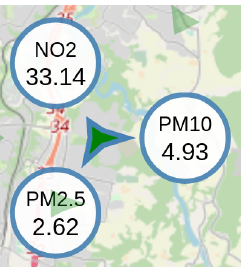
Figure 9. Close-up of a star glyph used in the map view. Each spike angle corresponds to a different type of measurement. The larger the spike’s length, the larger the corresponding measurement. The numeric details as shown here appear upon mousing over a selected